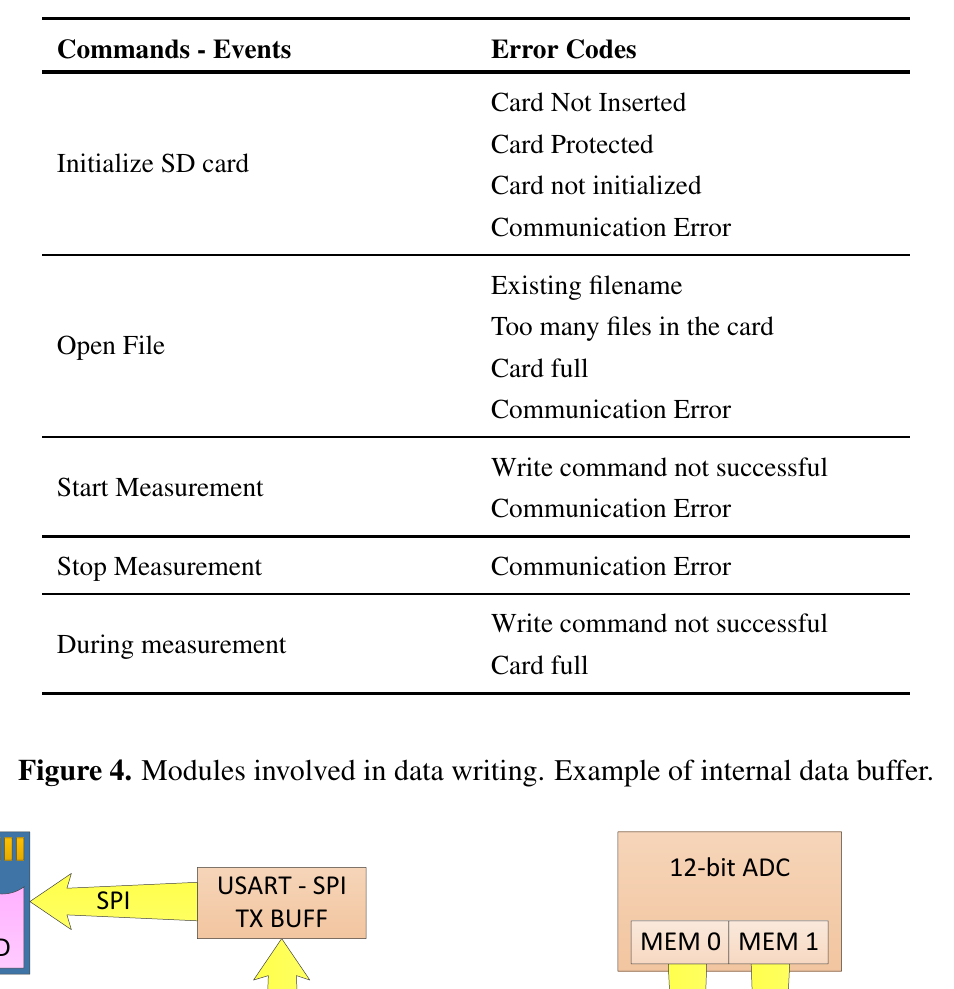
Table 2. Commands or events and error codes.